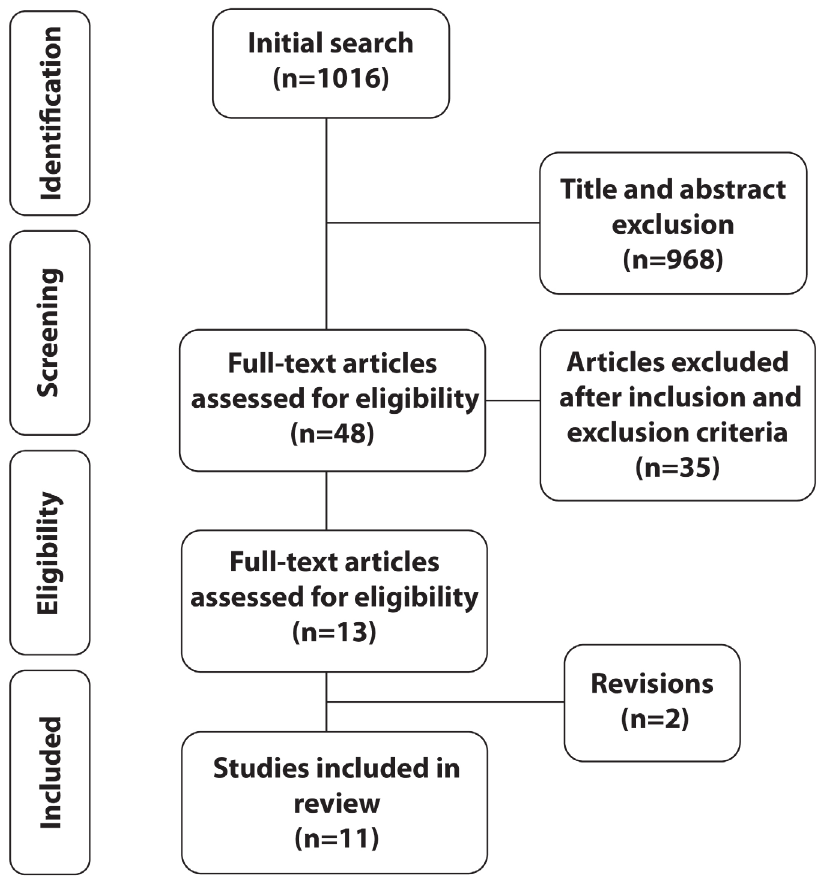
Fig. 1 - Preferred Reporting Items for Systematic Reviews and Meta-Analyses